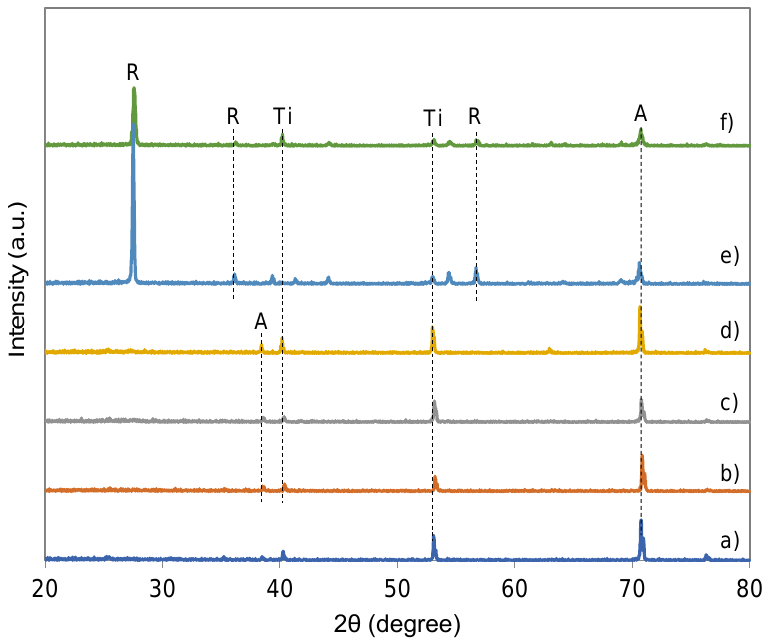
Figure 2. XRD patterns of TNTs. Calcination temperature: 300 ◦ C for ( a , b ), 500 ◦ C for ( c , d ), and 700 ◦ C for ( e , f ). ( a , c , e ) before irradiation. ( b , d , f ) after